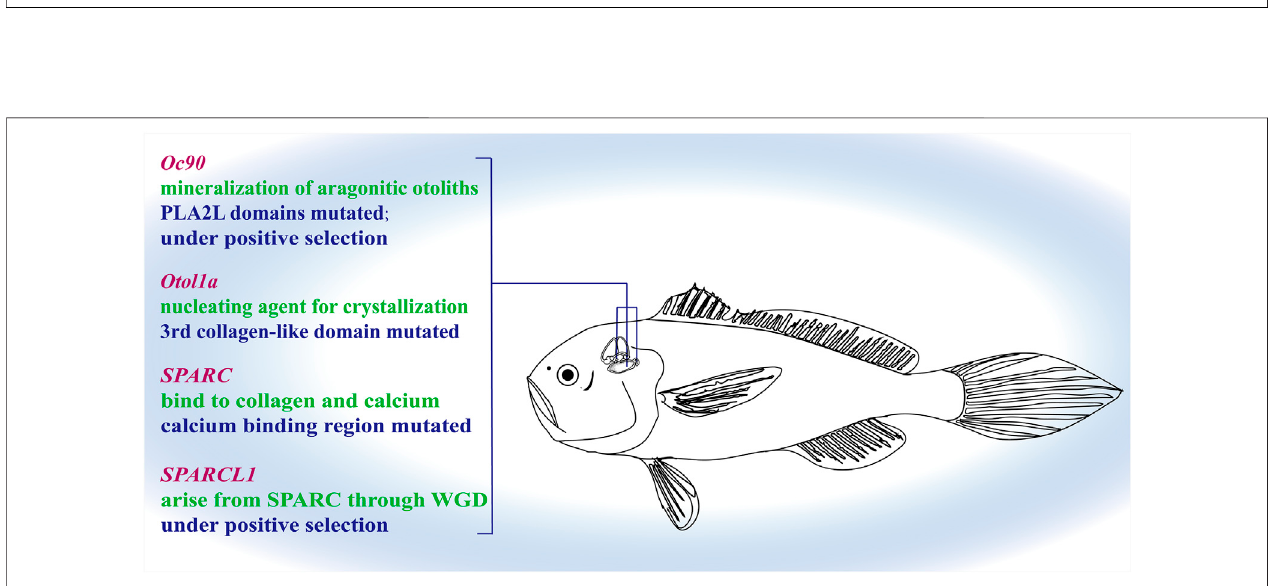
FIGURE 5 | Genetic changes in candidate otolith related genes of the family Sciaenidae. We found that Oc90, Otol1a, and SPARC contained some mutated sites, and Otop1 and SPARCL1 were under positive selection in Sciaenidae.